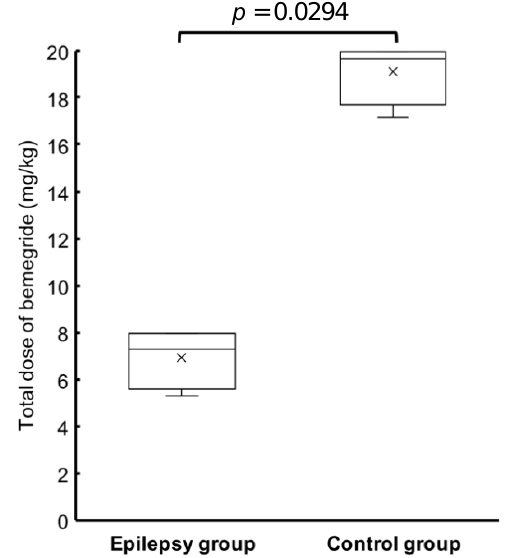
Figure 4. Comparison of the bemegride dose required to enhance or induce EDs between epilepsy and control groups. The vertical line shows the dose. The horizontal line in both boxes represents the median dose. The cross represents the mean dose. The vertical line below the box represents the first quartile of the data. The dose of bemegride was significantly lower in the epilepsy group than in the control group ( p = 0.0294).